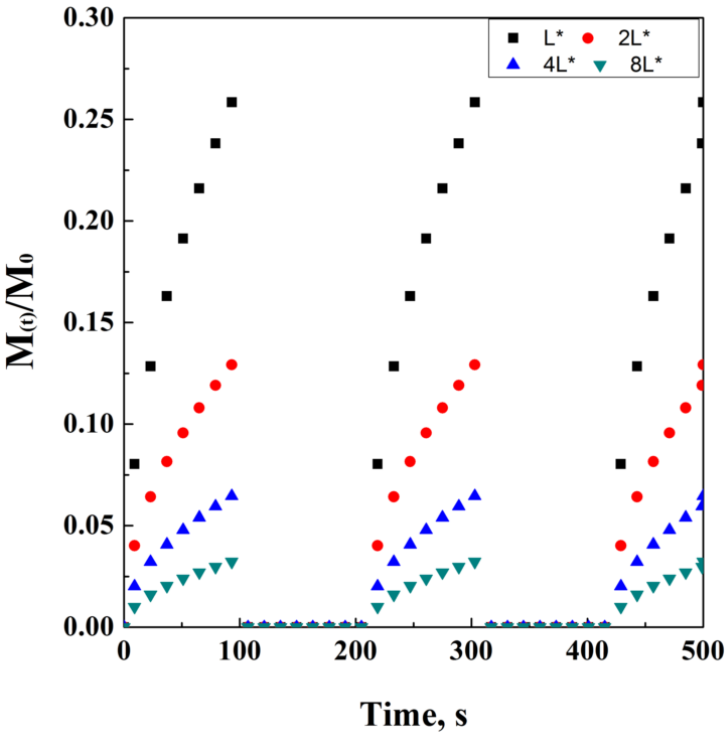
Figure 9. An example of pulsed delivery, adapted from the Crank and Baker parametric, on thickness L .